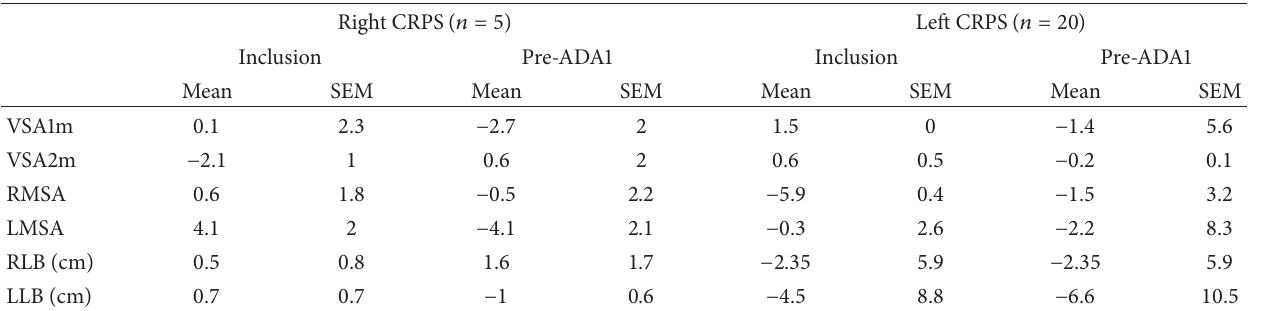
Table 2: Spatial reference frame deviation for patients at inclusion and before the first adaptation (mean and standard error of the mean). Right CRPS (𝑛 = 5)